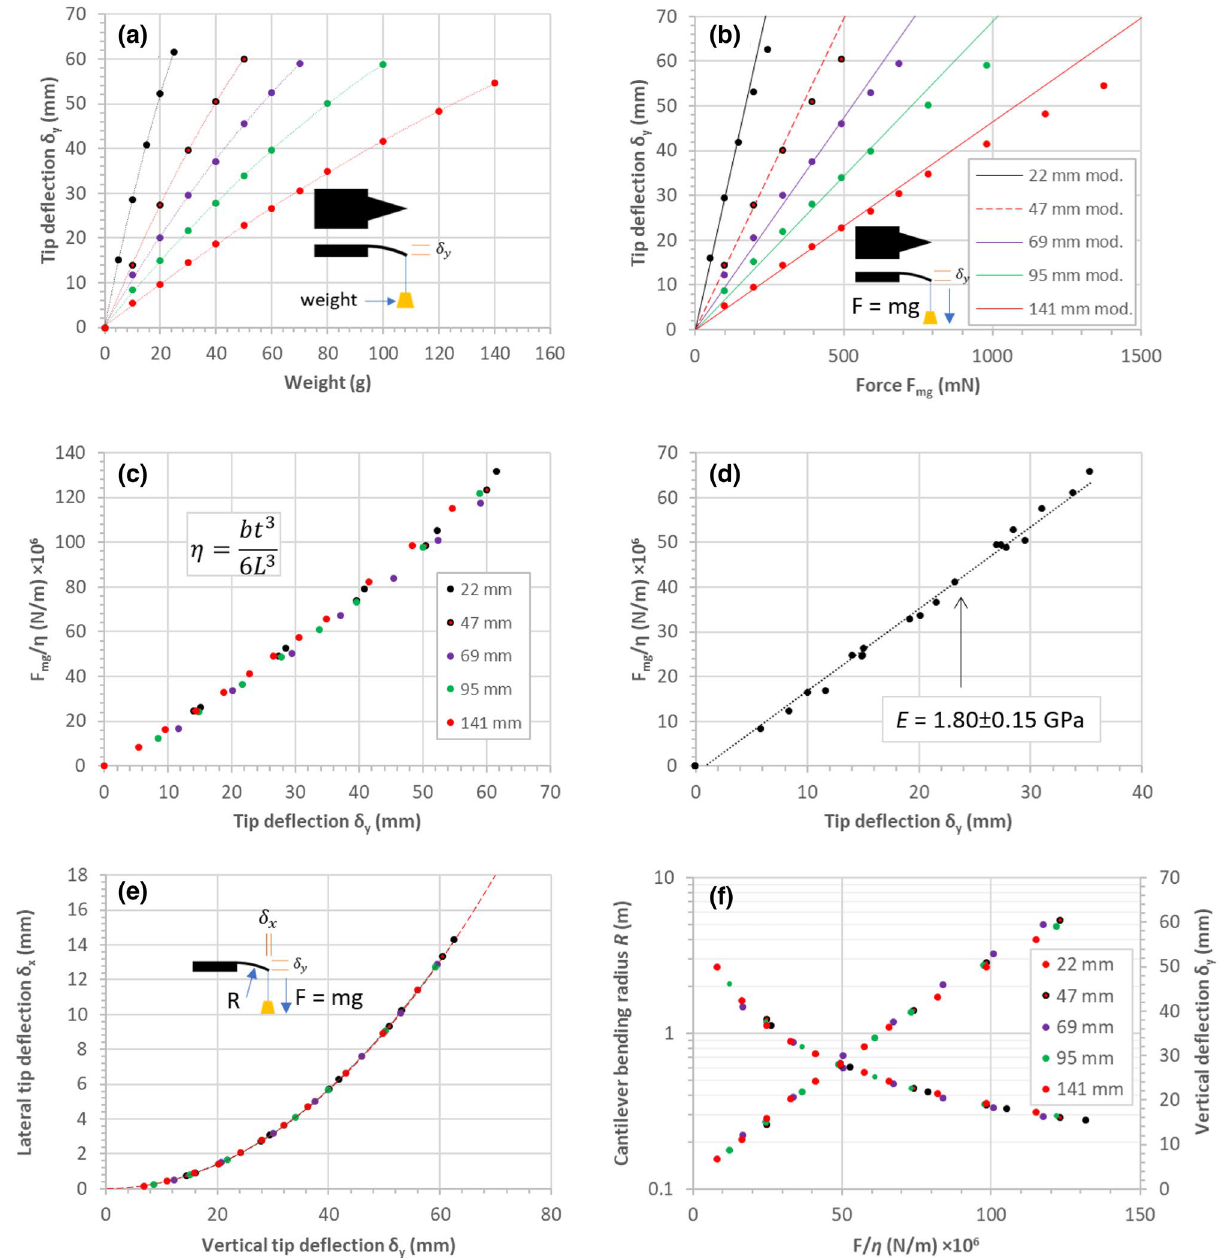
Figure 9. Experimental results of triangular cantilevers bending due to a concentrated load at the tip. ( a ) Tip deflection versus weight. ( b ) Tip deflection versus concentrated load force. ( c ) The factor F /η of all data plotted as a function of tip deflection. ( d ) Plot of the linear portion of graph ( c ). ( e ) Plot of the lateral tip deflection versus the vertical tip deflection for all data. ( f ) Plots of the cantilever bending radius and the vertical tip deflection versus the factor F /η for all